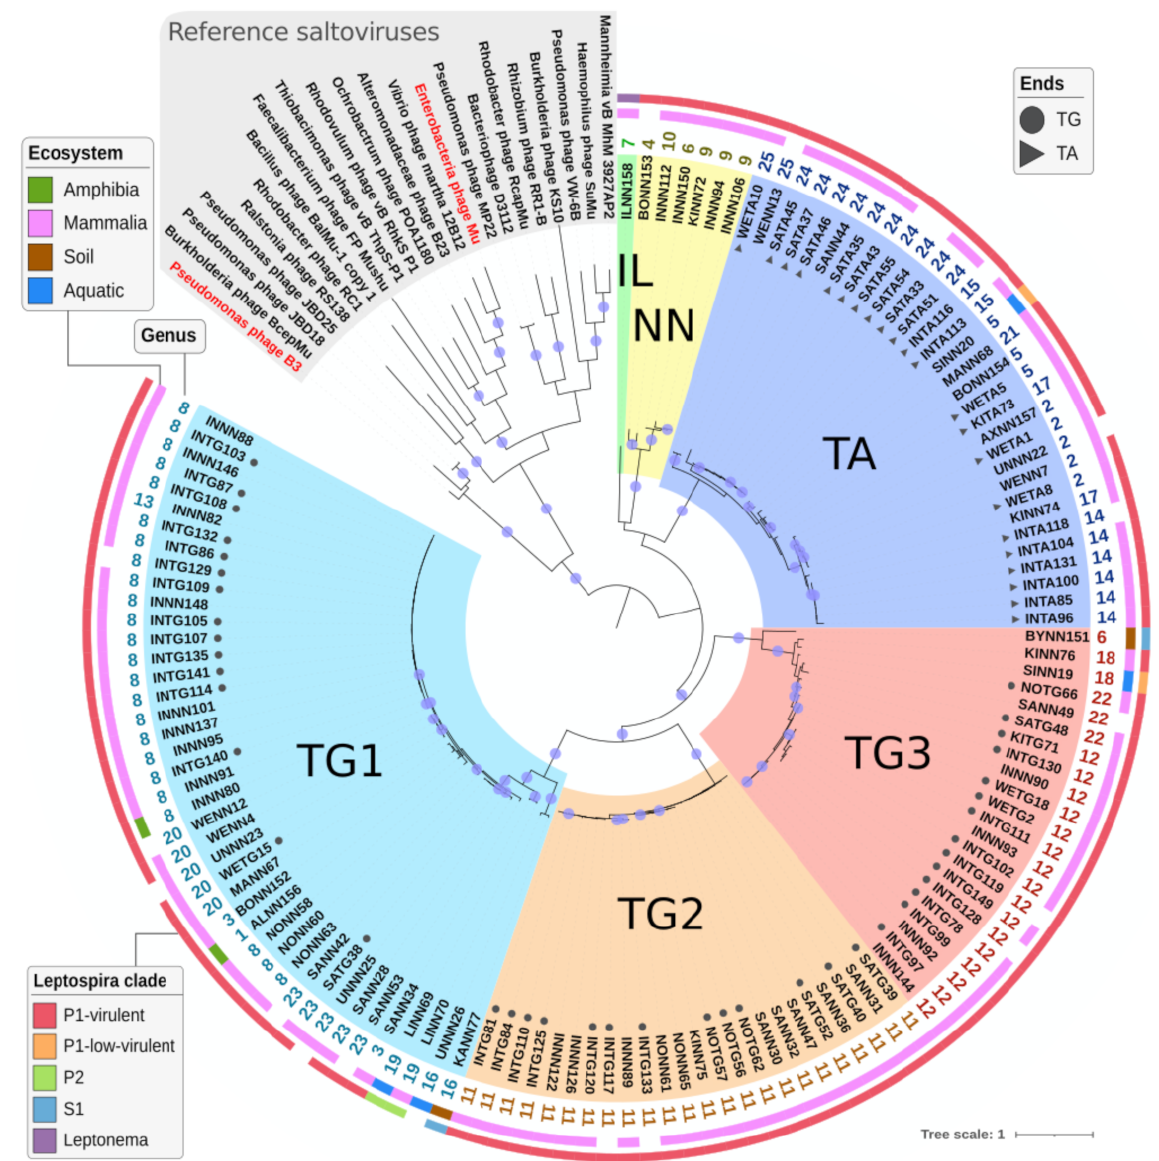
Figure 2. Phylogeny from the concatenation of TnpA and TnpB computed with RAXml. Bootstrap supports greater than 80 are indicated on internal branches by blue circles. Reference transposable phages are colored in grey at the top, with phage Mu and B3 printed in red. The 126 prophages (representative of the 126 prophage species) are separated into six clades, each with a different color, e.g., the TA clade in dark blue. Prophages for which exact ends were determined are indicated with a filled circle or triangle for TG-CA and TA-TA ends, respectively. Displayed as three outer circles are: (i) the genera number of each prophage calculated by VIRIDIC (from 1 to 25), (ii) the ecosystem in which the Leptospiraceae host was isolated, and (iii) the leptospiral clade of the